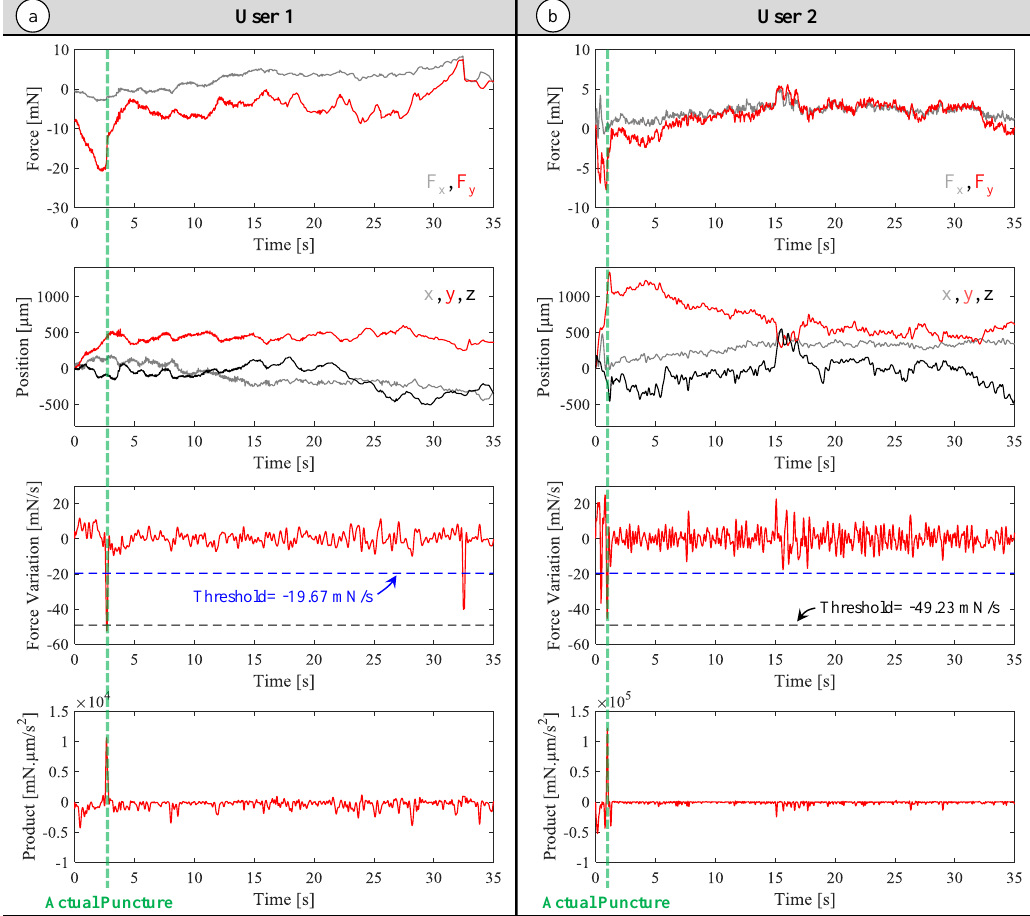
Figure 10. Measurements from a sample trial for each user: needle tip force (F x in grey, F y in red), needle tip position (x in grey, y in red, z in black), the variation of force ( d|F⃗ needle | dt⁄ ) and the inner product of tool velocity and variation of force ( dF⃗ needle dt⁄ ∙ dp⃗ needle dt⁄ ). The timing of the actual puncture in each trial is marked with a green dashed line. ( a ) Data for the first user: The elevated threshold (the dashed blue line at d|F⃗ needle | dt⁄ = −19.67 mN/s ) may intersect the time derivative of force multiple times, and may trigger faulty detections after the actual puncture. ( b ) Data for the second user: The low threshold (the dashed black line at d|F⃗ needle | dt⁄ = −49.63 mN/s ) fails to intersect the force variation curve while the elevated threshold intersects it twice, leading to a faulty detection before the actual puncture using the force-based method. In both trials, the inner product of the force variation and tool velocity clearly displays the instant of actual puncture with a prominent positive peak. The force-and-position-based method, relying on the inner product value, is able to distinguish the event of puncture.